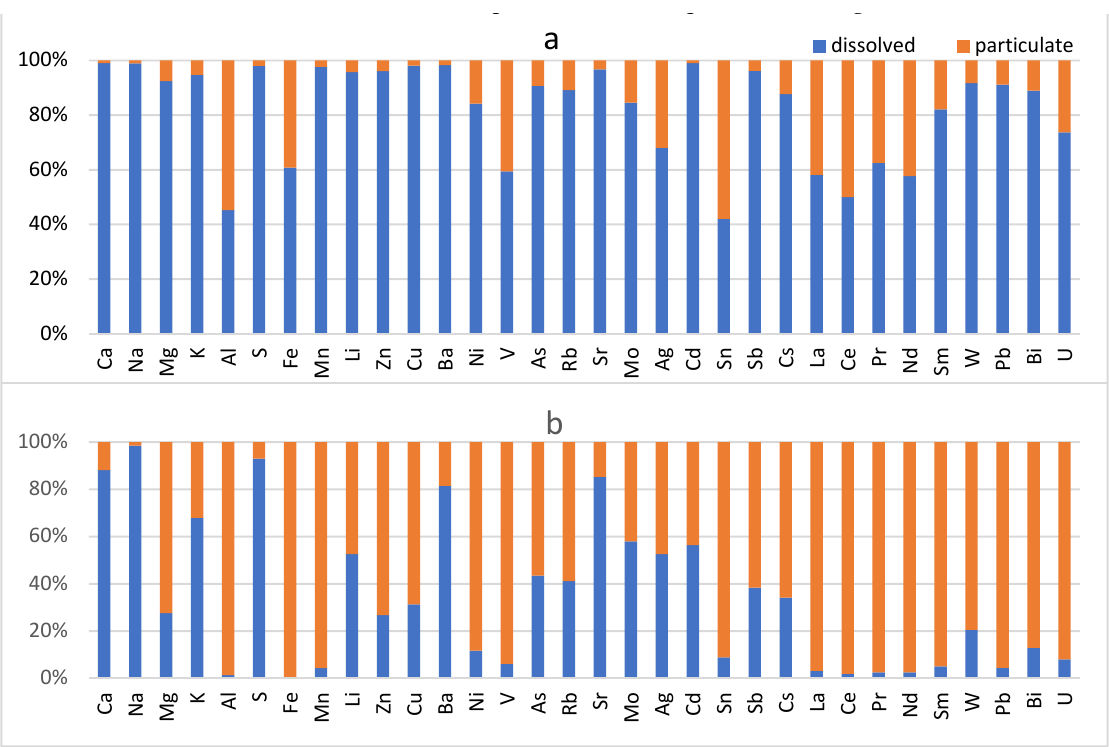
Figure 3. Proportions of dissolved (1) and particulate (2) forms of elements in the background area ( a ) and Tyumen City ( b ). The values of CF, characterizing the surplus of element concentration within the city as compared to the background, were significantly higher in the particulate phase as compared to the dissolved phase (Figure 4). This is connected with a higher rate of dust deposition within the city, as well as a higher total concentration of TMMs in the dust. It should be mentioned that concentrations of dissolved forms of some elements (Mn, Fe, Co, Cu, Zn, As, Cd, Sn, Pb and Bi) within the city were lower than those in the background, with CF < 1 (Figure 4). This finding is paradoxical, taking into account that the deposition rate of metals in particulate forms had multiplied by tens and hundreds of times within the city. Nevertheless, similar situations have been reported in previous studies. For example, Viklander [68] detected a decrease in the dissolved Pb concentration in the sites affected by heavy traffic in comparison with that in background sites. Possible explanations can include either the coagulation of small (d = 0.8–1.5 µ m) particles of dissolved fractions into larger (d = 50–600 µ m) insoluble particles [69], or the adhesion of smaller to larger particles that would also decrease the content of dissolved forms